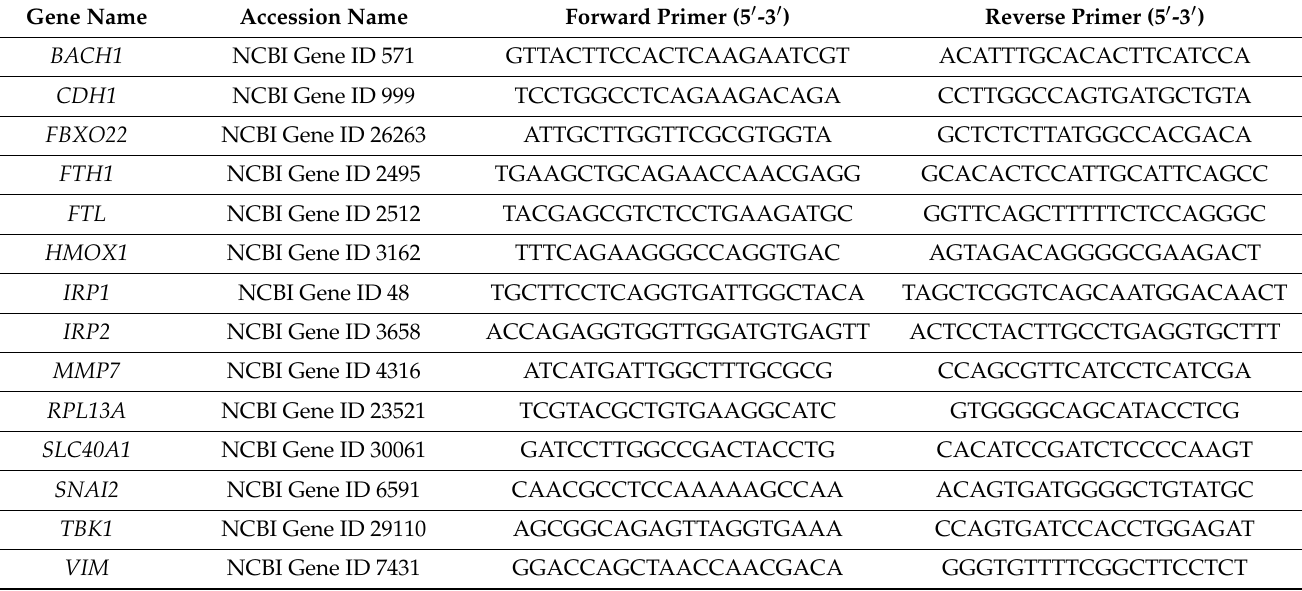
Table 2. Sequences of qPCR